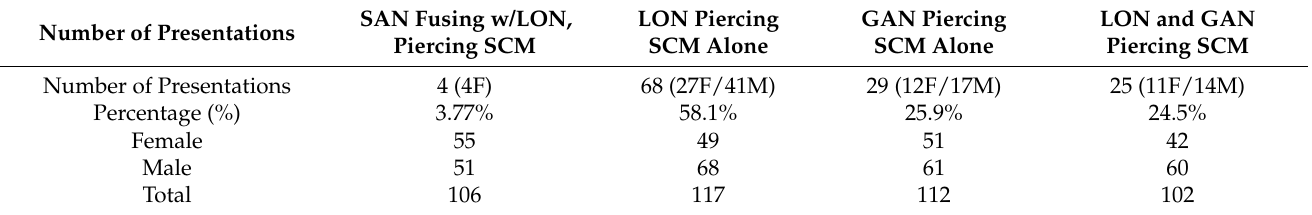
Table 1. Data on the number of anatomical specimens identified with each nerve variant, broken down by sex (M = males, F = females). Abbreviations: GAN = greater auricular nerve; LON = lesser occipital nerve; SAN = spinal accessory nerve; SCM = sternocleidomastoid.